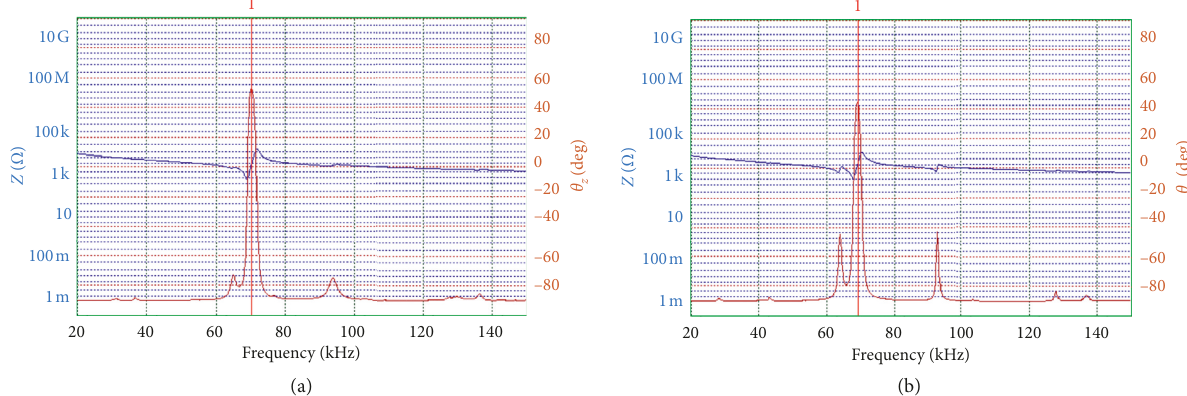
Figure 13: Results of impedance and phase angle spectra measurement of ring-type transducers: measurement of upper transducer, driving frequency is 69.0 kHz (a); measurement of lower transducer, driving frequency is